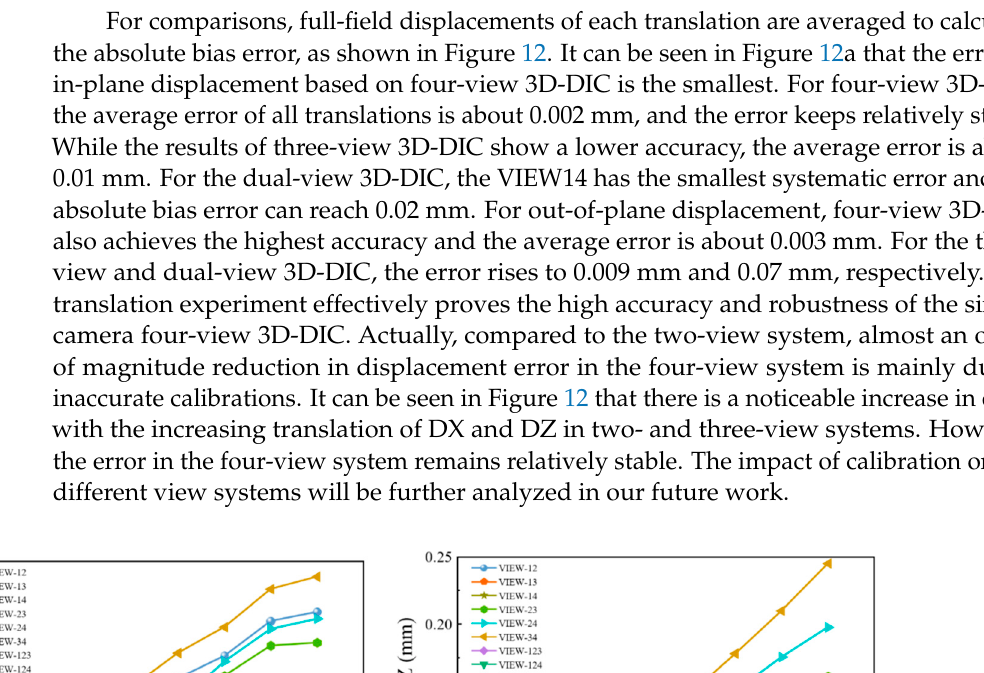
Figure 11. Translation experiment for: ( a ) experiment setup; ( b ) specimen and translation stage.